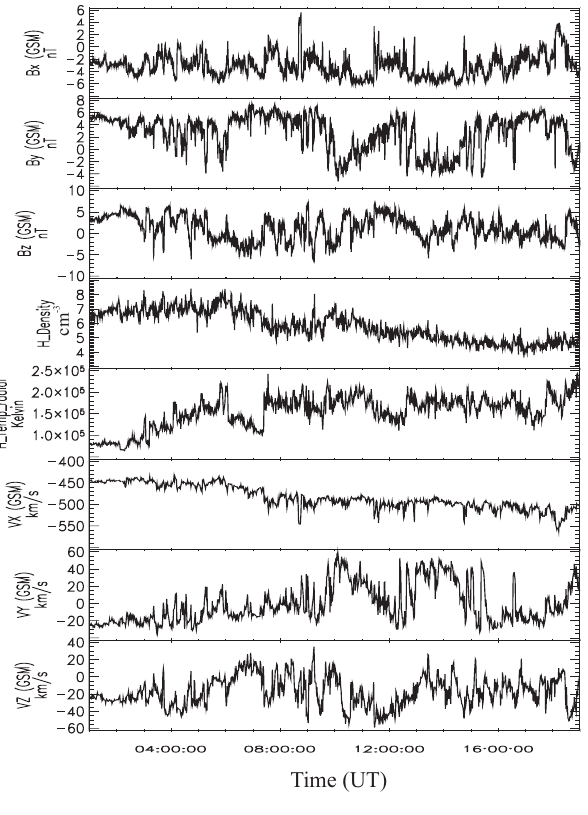
Fig. 1. WIND magnetic field, velocity, thermal velocity and number density observations for 7 June 2000.